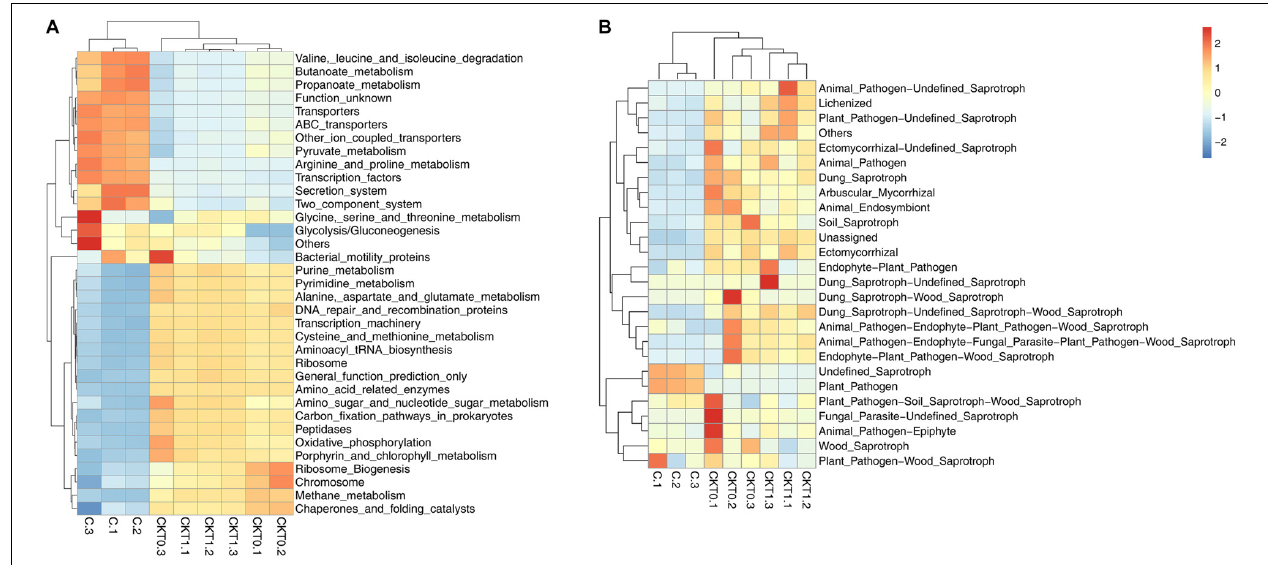
FIGURE 12 | Predicted bacterial (A) and fungal (B) functional analysis of soil amended with or without catalpol. Soil treatments were incubated for 60 days at 26 ◦ C at 50% humidity. CKT0 and CKT1 represent control soil without catalpol and collected at experimental initiation (T0) and termination (T1), respectively. C represents soil amended with catalpol for 60 days. Experimental means are the average of three